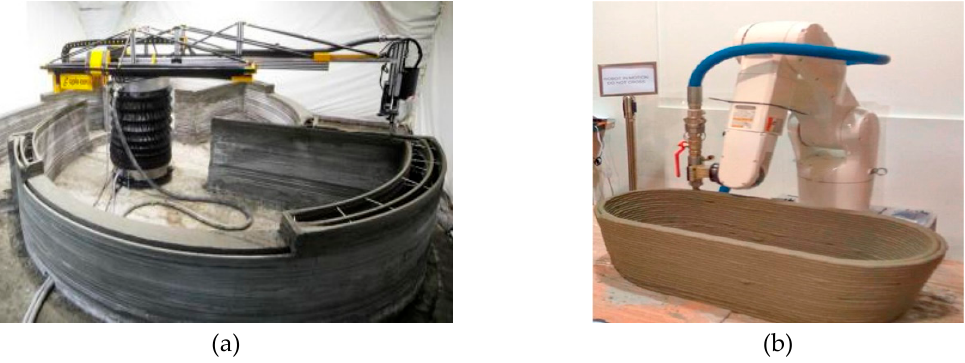
Figure 3. ( a ) Apis Cor 3D printer (Reproduced from [12]) and ( b ) SC3DP six-axis robot (Reproduced with permission from: [16], Virtual and Physical Prototyping; published by Taylor & Francis Group,